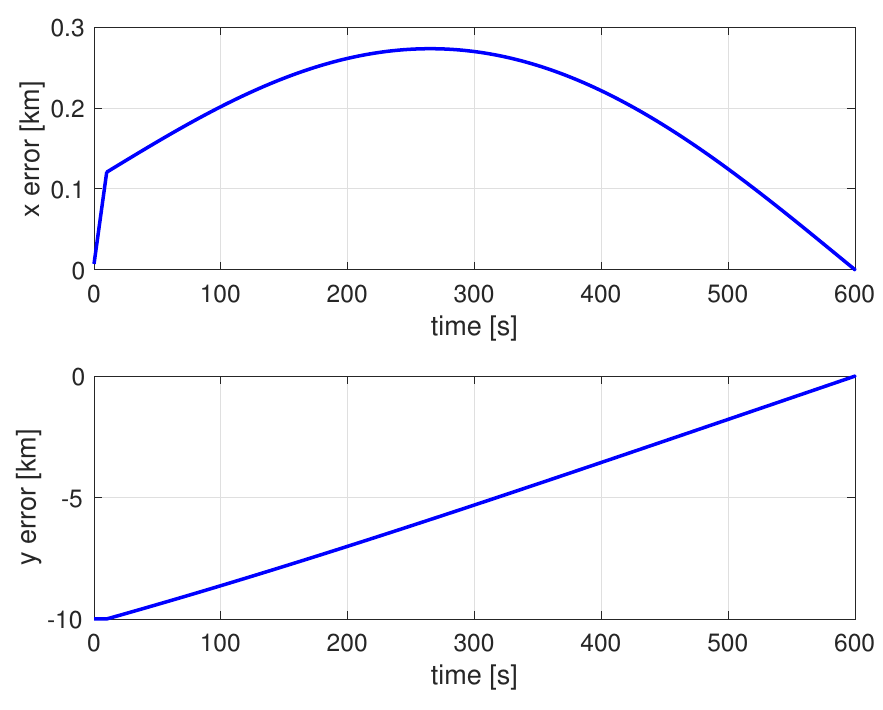
Figure 2. Position errors in the x and y